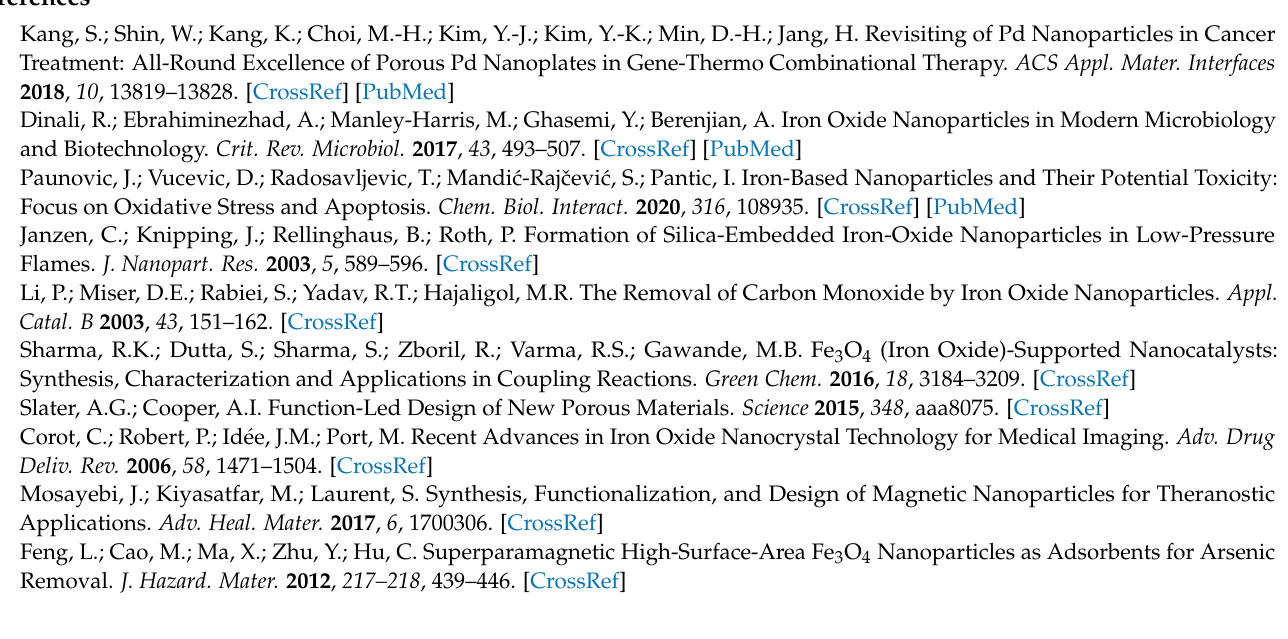
Figure S1. Particle size distribution of nanoparticles from TEM images. Figure S2. SEM images of iron oxide nanoparticles synthesized in the absence of F127. Figure S3. The obtained mass spectra at various stages after the treatment with Fe 2 O 3 nanoparticles. Figure S4. mass spectra of 20 ppm CR (a) before and (b) after treatment with IONPS and H 2 O 2